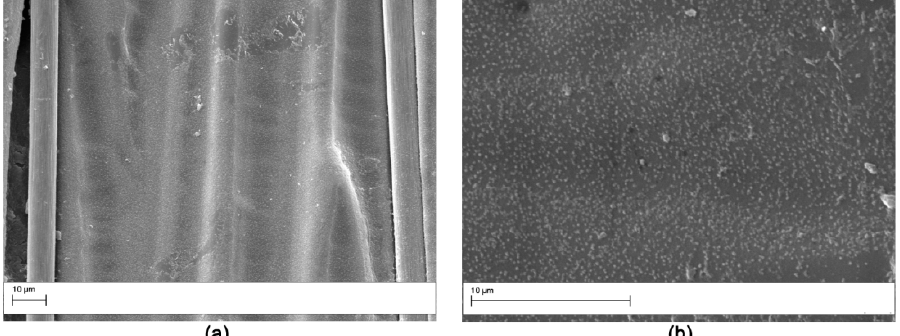
Figure 15. SEM of the fracture surface for the V2 modified DCB sample: low magnification (2000 × ) ( a ); high magnification (10,000 × ) ( b ).